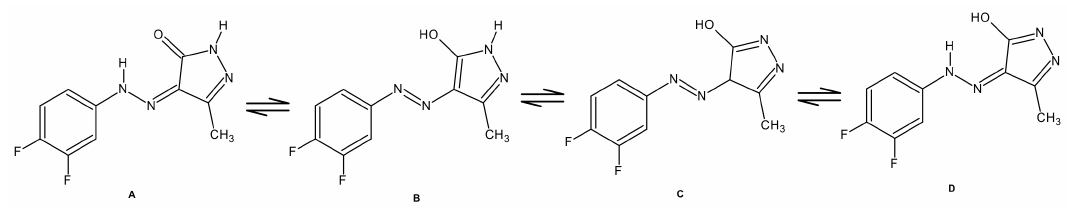
Figure 1. Possible tautomeric structures of compound 4